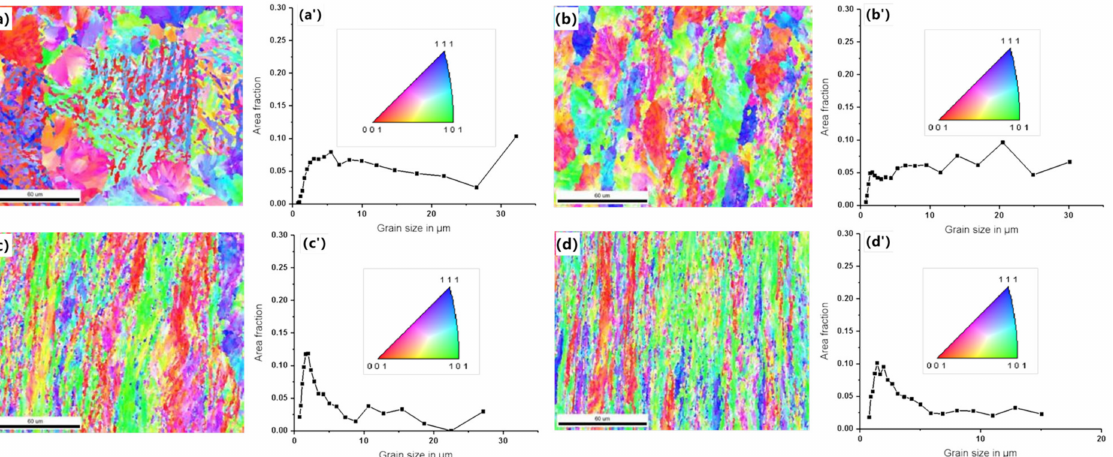
Figure 8. Variation of crystallographic orientation and grain size distributions at different deformation strains: ( a , a (cid:48) ) 20%, ( b , b (cid:48) ) 40%, ( c , c (cid:48) ) 60%, ( d , d’ ) 75%.